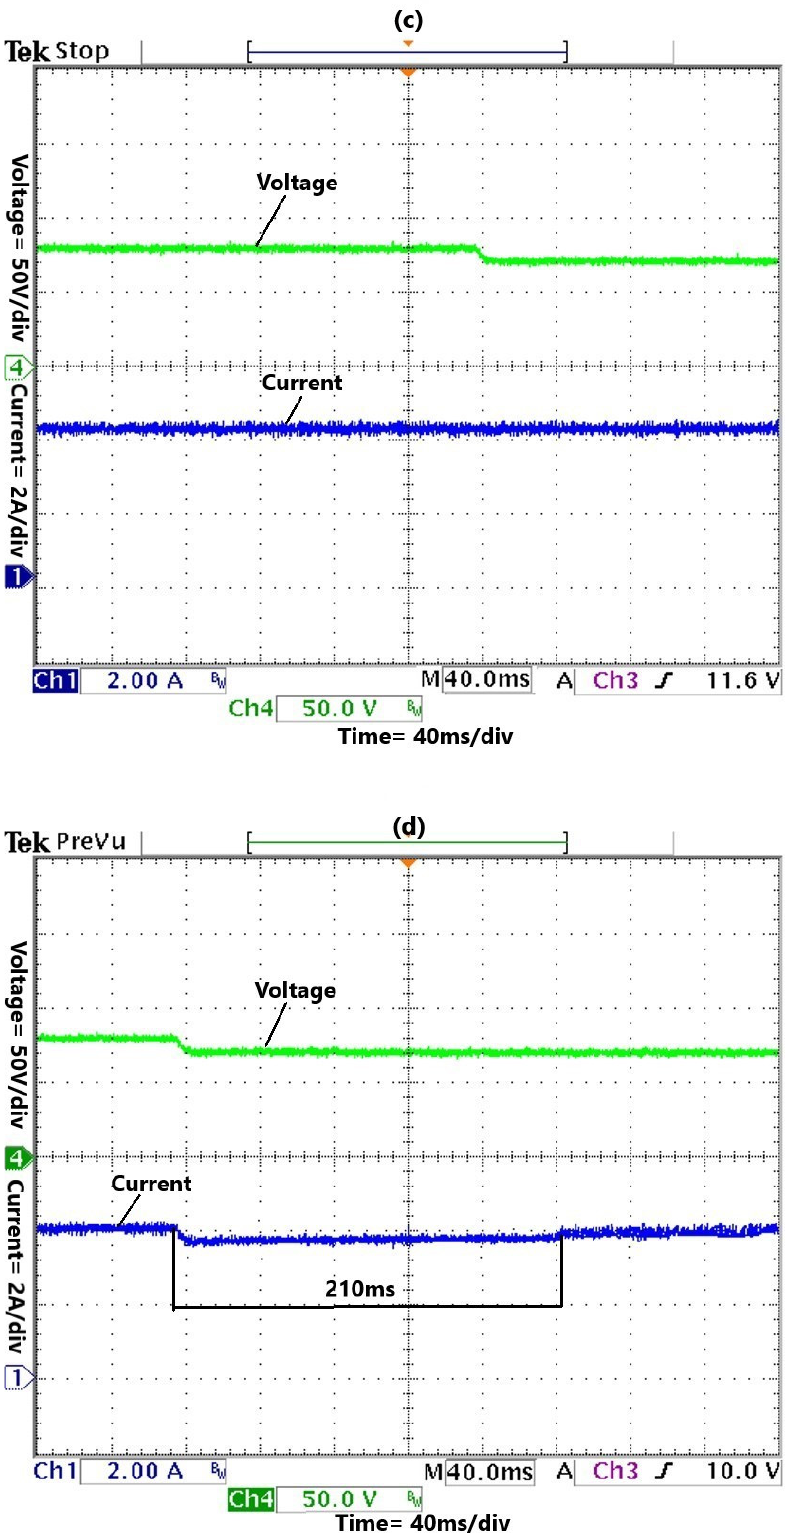
Figure 17. Experimental results during input voltage step-down (75 V to 65 V): ( a ) FCC; ( b ) LCFF; ( c ) MBPS; ( d ) PI.